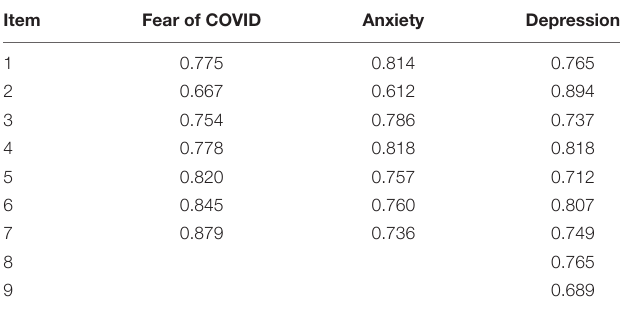
TABLE 4 | Standardized factor loadings for all the latent variables.